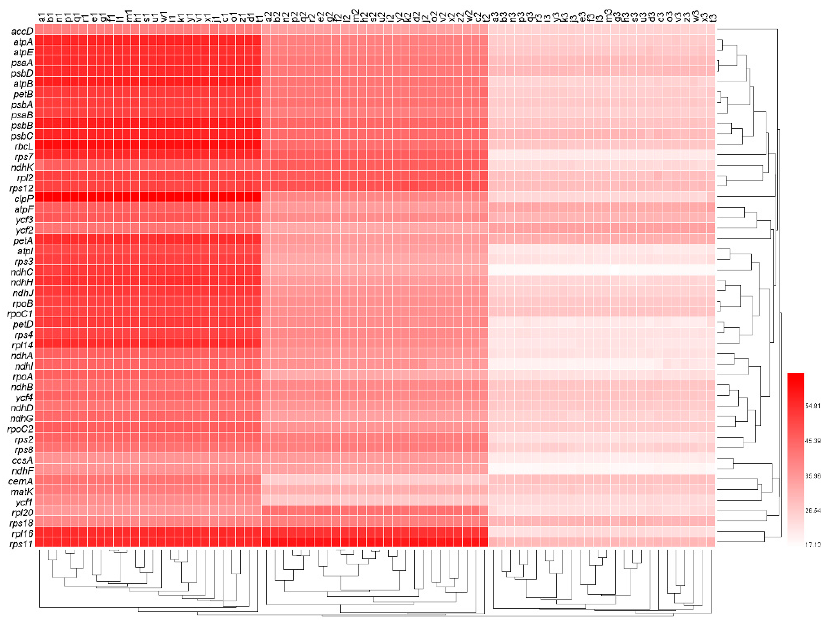
Figure 1. The nucleotide composition at the first, second, and third codon positions of all genes. The numbers next to the legend indicate the percentage of GC content. Lowercase letters from a to z at the top of the heat map represent the data sets of oak trees Q. rubra , Q. aliena , Q. spinose , Q. aquifolioides , Q. baronii , Q. variabilis , Q. dolicholepis , Q. tarokoensis , Q. glauca , Q. tungmaiensis , Q. sichourensis , Q. chenii , Q. acutissima , Q. dentate , Q. obovatifolia , Q. wutaishanica , Q. mongolica , Q. robur , Q. bawanglingensis , Q. coccinea , Q. phillyraeoides , Q. gilva , Q. pannosa , Q. virginiana , Q. acuta, and Q. chungii , respectively. The numbers 1, 2, and 3 after the lowercase letters represent the 1st, 2nd, and 3rd positions of the synonymous codons,